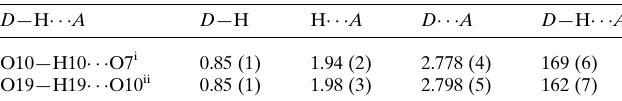
Table 1 Hydrogen-bond geometry (A˚ , (cid:5) ).